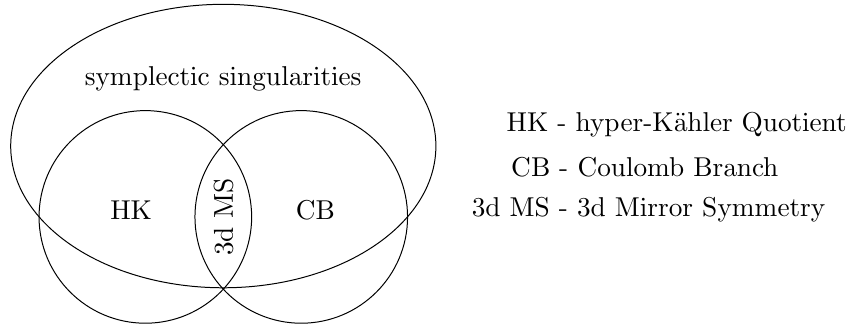
Figure 1 . One has to make a distinction between the various geometric spaces dealt with in the realm 3d N = 4 gauge theories. Examples of symplectic singularities are given through both the hyper-K¨ahler quotient and the Coulomb branch construction. The space of symplectic singularites which can be constructed as a Coulomb branch and as a hyper-K¨ahler quotient, is the realm of the famous 3d mirror symmetry. However, there are Coulomb branches for which no hyper-K¨ahler quotient construction is known and vice versa. Furthermore there are hyper-K¨ahler quotients and Coulomb branches, which are not symplectic singularities. If the hyper-K¨ahler quotient is a union of symplectic singularities, the individual cones may be described as the Coulomb branches of a set of magnetic quivers. The hyper-K¨ahler quotient need not accurately describe the Higgs branch of the quantum moduli space of a theory, an example is given in section